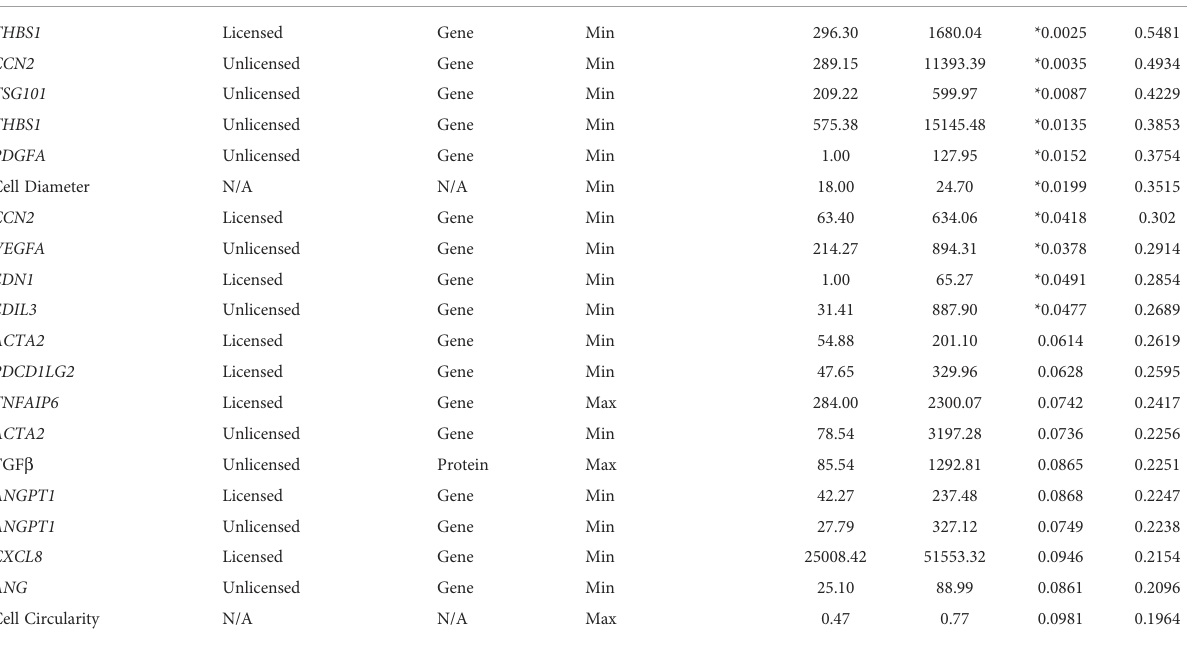
TABLE 2 Putative CQAs for MSC(AT) immunomodulatory fi